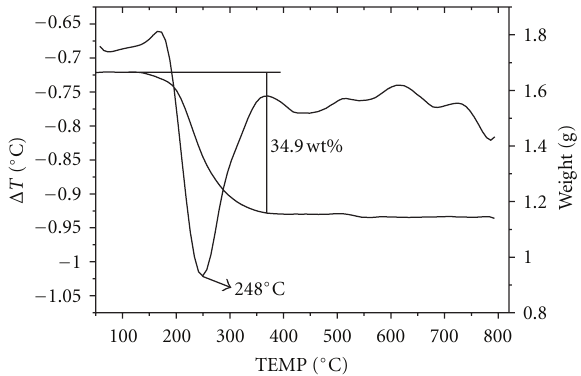
Figure 4: TG-DTA curves for the as-prepared dittmarite.